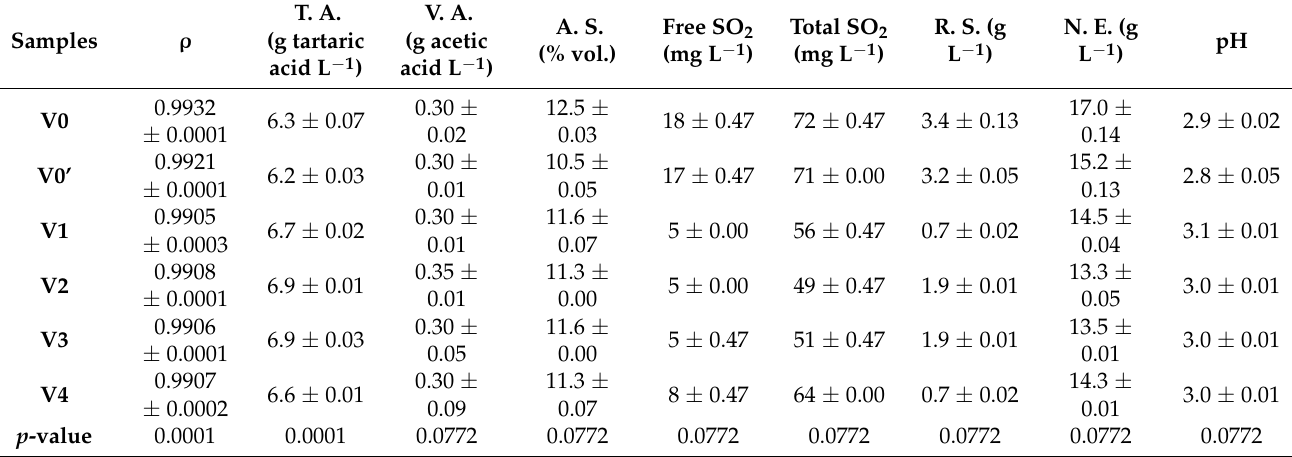
Table 1. Physical–chemical parameters of obtained